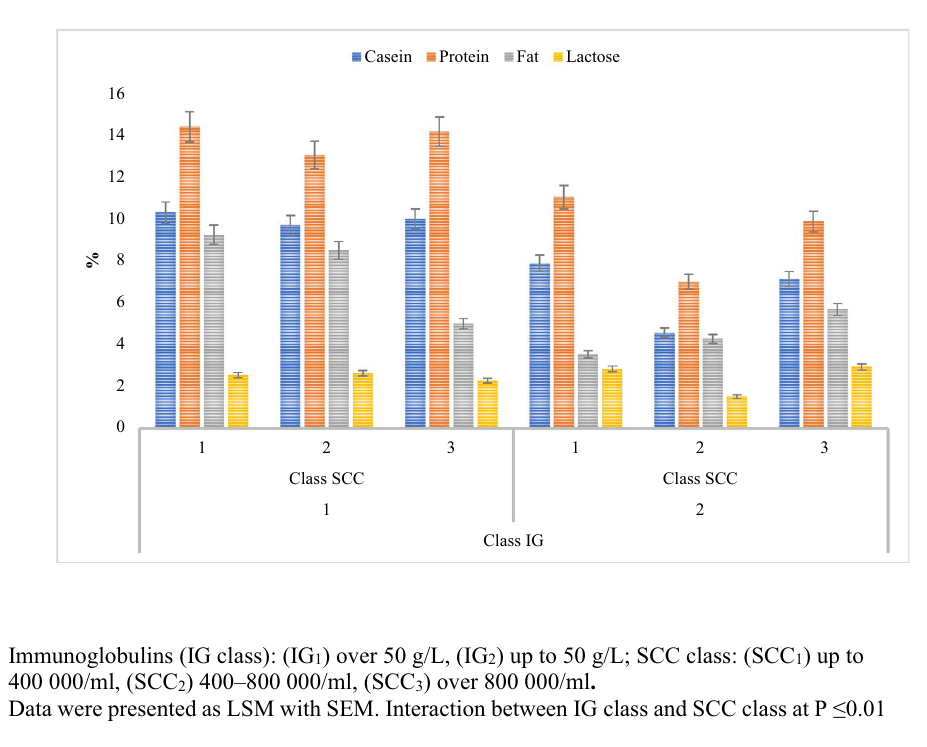
Figure 4. Interaction between the level of immunoglobulins and SCC as a factor shaping the basic chemical composition of colostrum